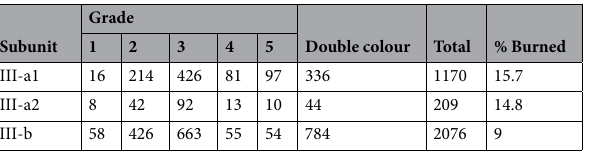
Table 4. Number of burned bone remains according to grades of colour